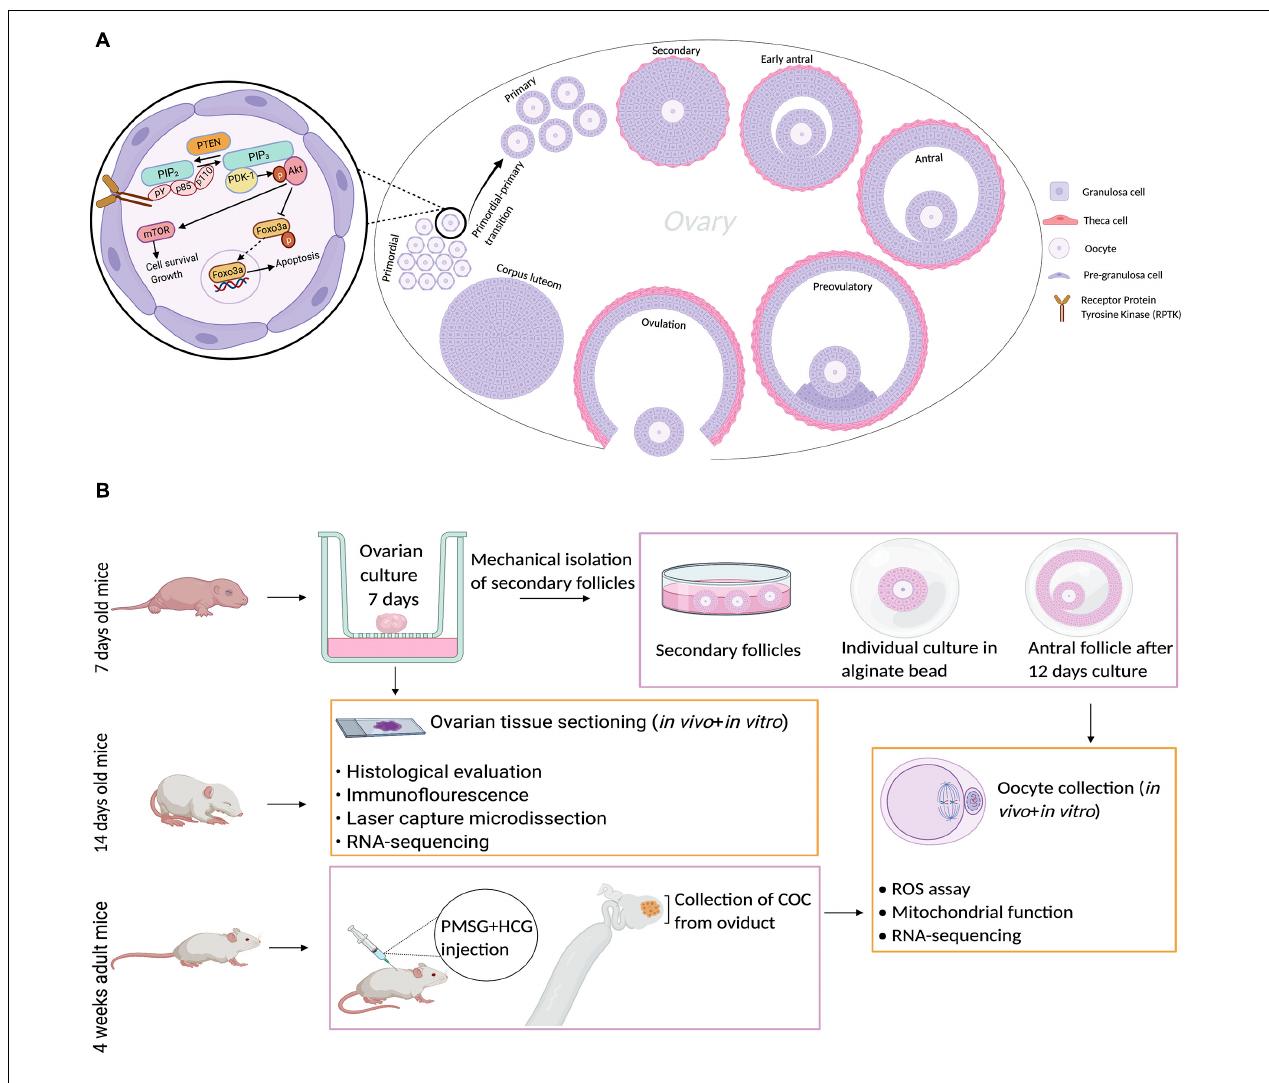
FIGURE 1 | Schematic images representing mammalian ovaries and the experimental design. (A) Different developmental stages of follicles are shown from primordial follicles to ovulation and formation of the corpus luteum. The PTEN–AKT–FOXO3 signaling pathway is represented in higher magnification of one primordial follicle, showing its role in the primordial–primary follicle transition. Dimerization and autophosphorylation of RPTK molecules result in the generation of PIP 3 from PIP 2 . PTEN is a negative regulator of PI 3 K, which converts PIP 3 to PIP 2 . Akt is activated by binding to PIP 3 and phosphorylated by PDK1. Activated AKT leads to phosphorylation of Foxo3a and its localization in the cytoplasm, preventing relocation of unphosphorylated Foxo3a to the nucleus to induce